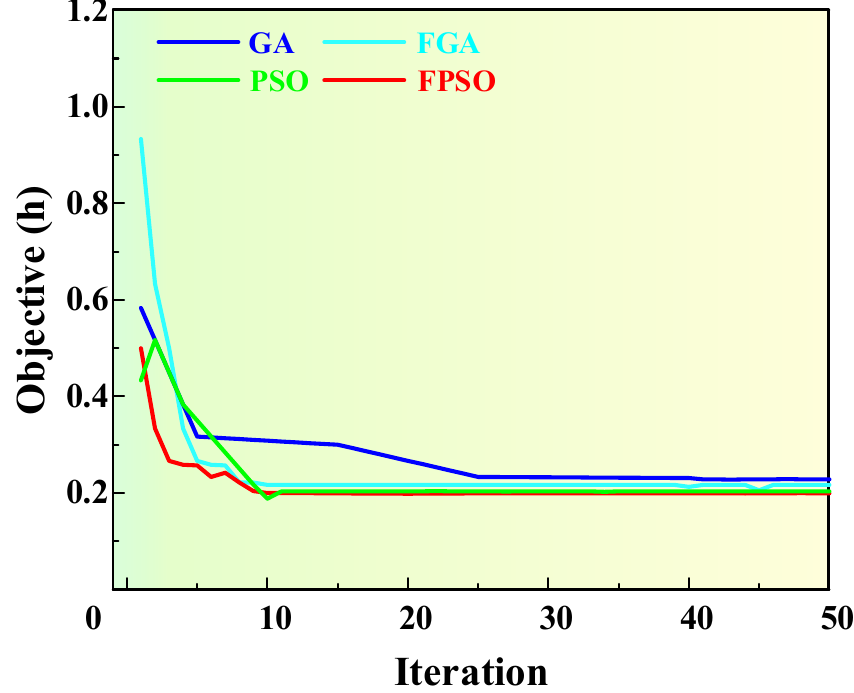
Figure 20. Iterative diagram of different algorithms at a certain stage. Table 4. Calculation results of different solving algorithms for the RFC with eight ballast tanks.